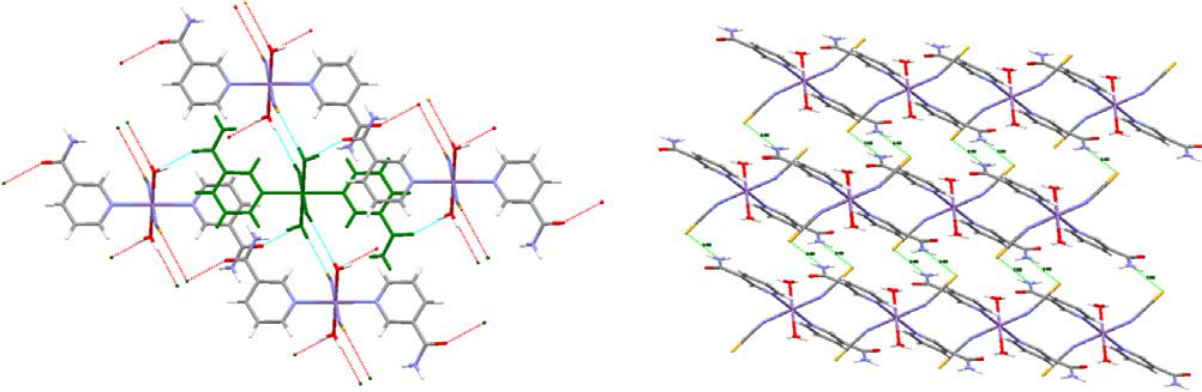
Figure 2. Hydrogen bond network/packing diagram in 1 leading to formation of layers (left) that get connected via N3–H3A···S1 hydrogen bond